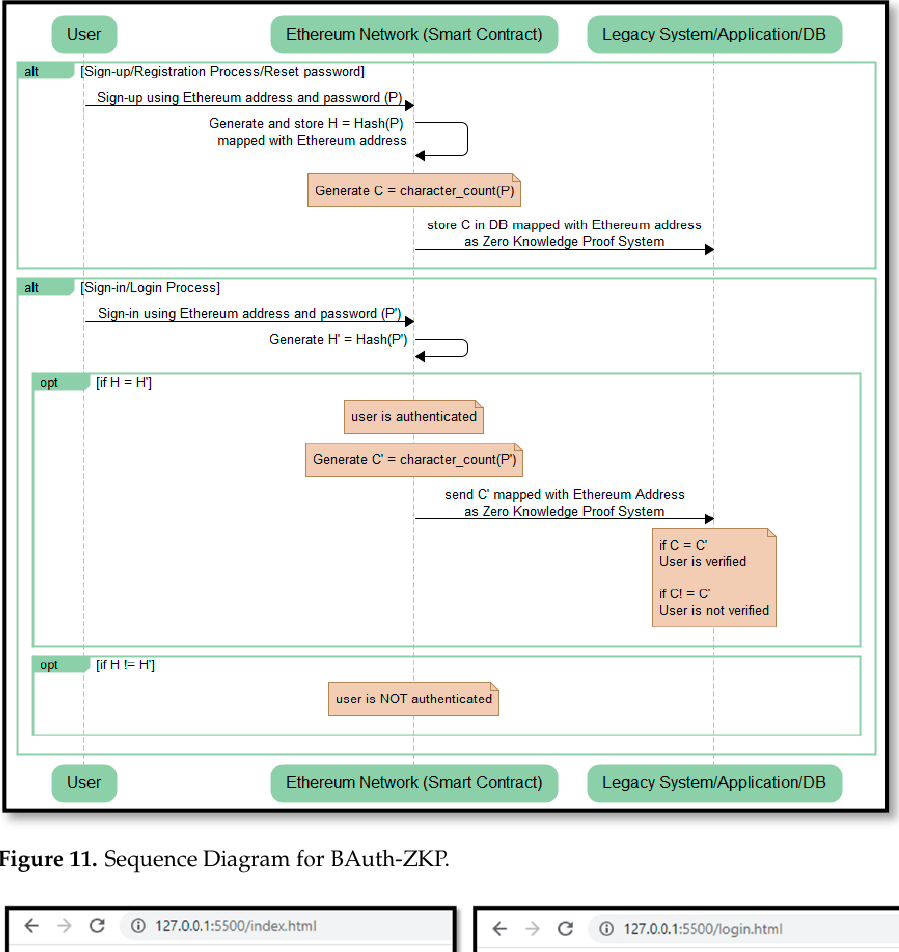
Figure 11. Sequence Diagram for BAuth-ZKP.